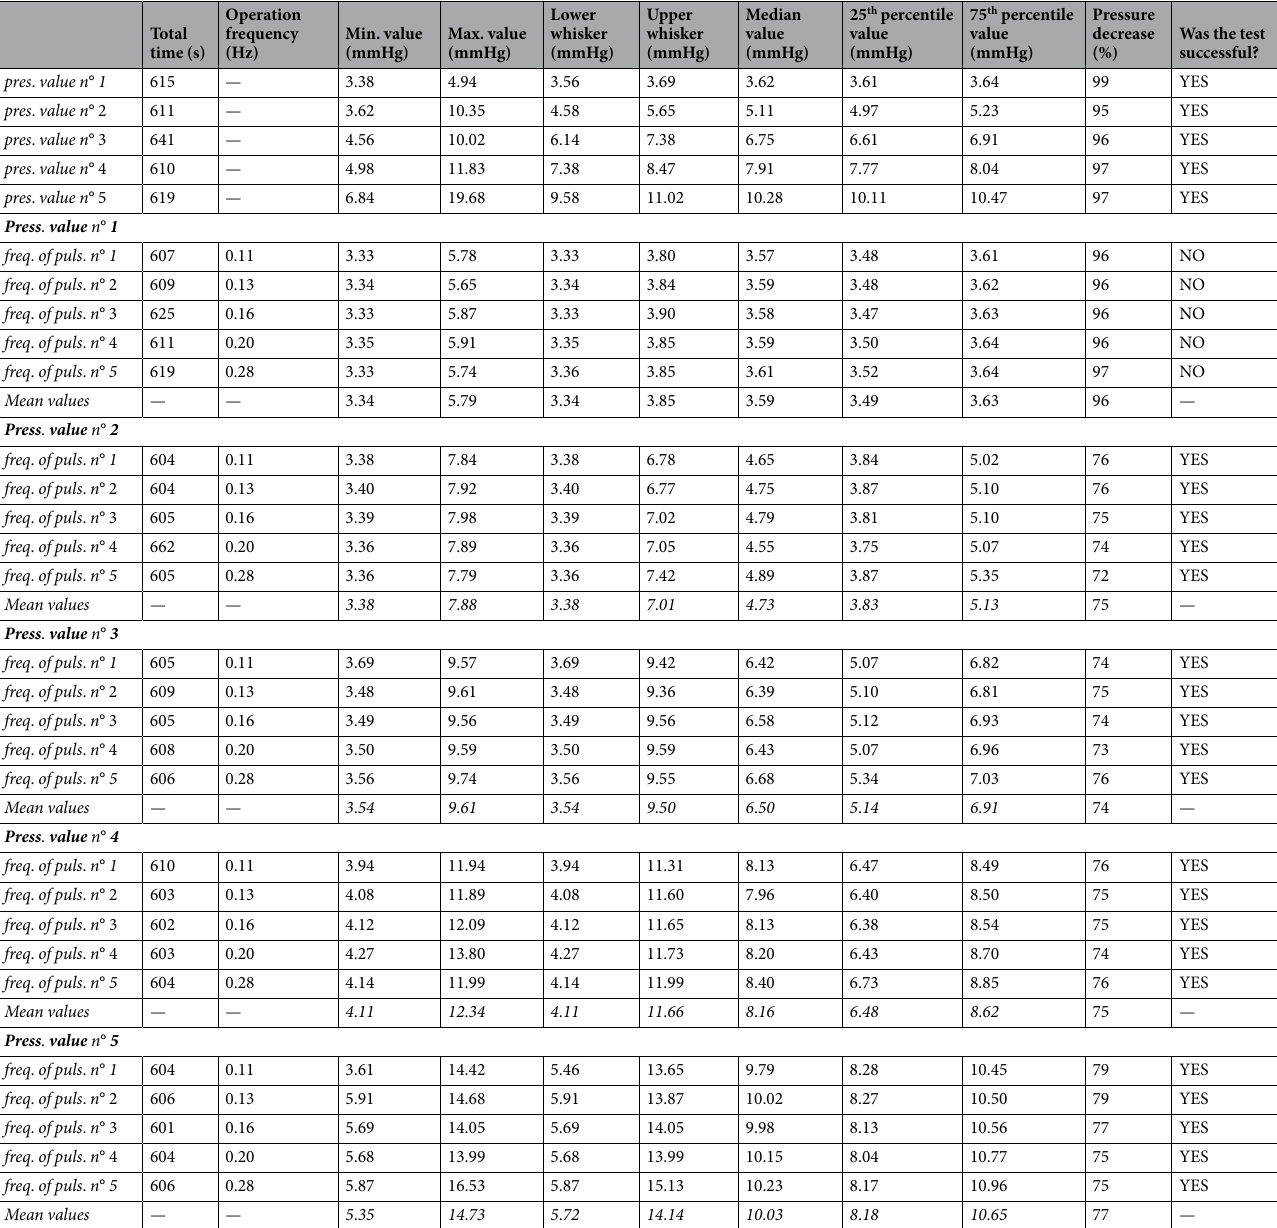
Table 1. Results of the electro-pneumatic device’s performance in the laboratory